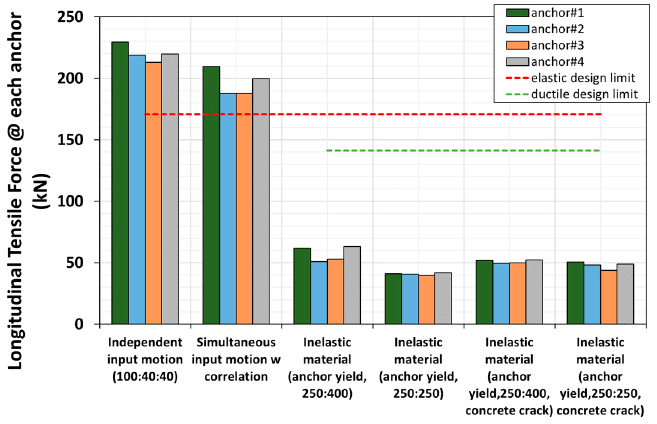
Figure 18. Anchor forces under tension (M24, pushover analyses).